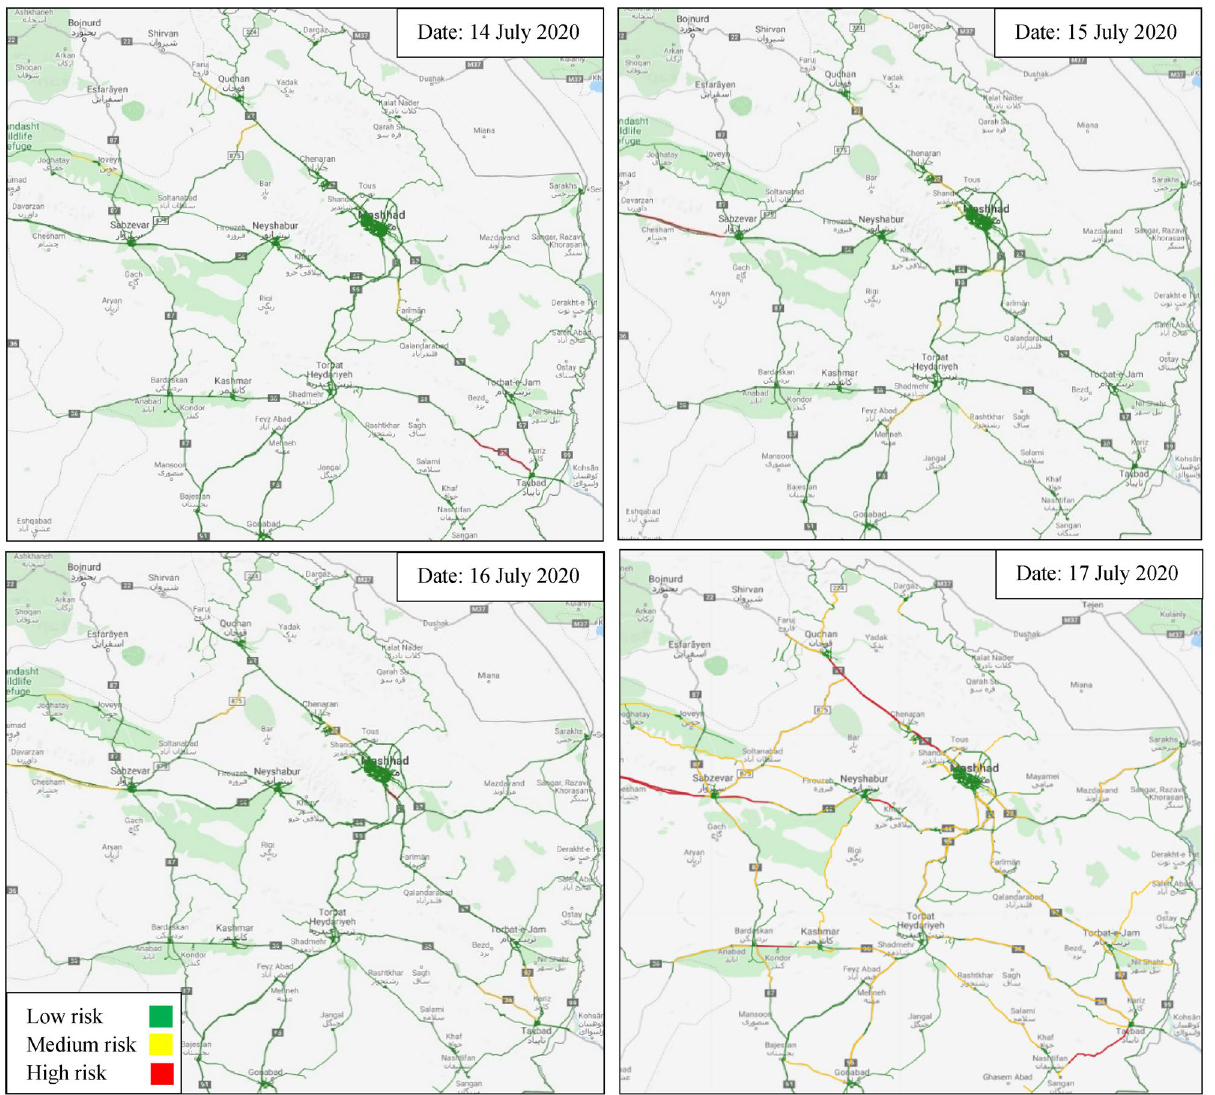
Figure 7. Risk map of the rural road network in Khorasan Razavi from 14 to 17 July 2020 [Maps Data: https:// www. opens treet map. org, Modified Map: Python